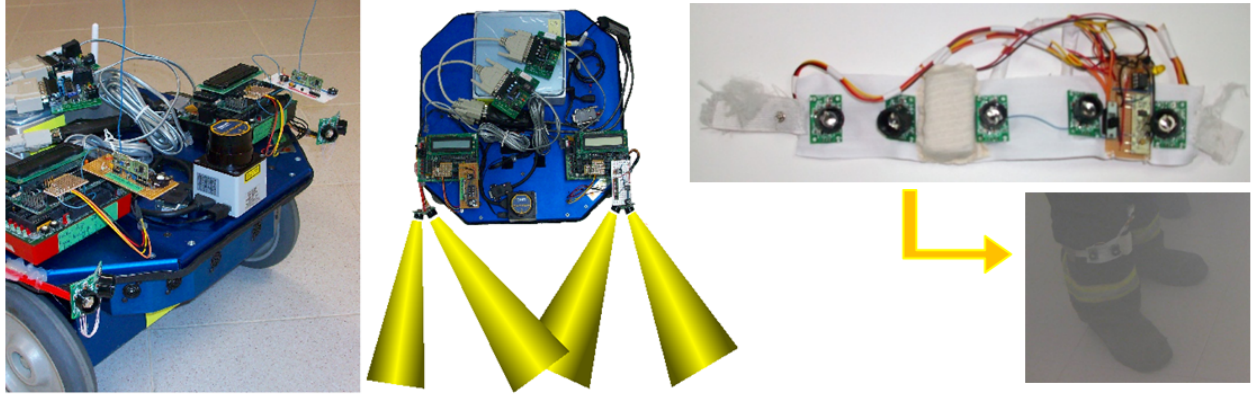
Figure 10. Erratic Videre mobile platform equipped with 2 measurement boards based on TDoA (left). Ultrasonic beam patterns (center). Sonar elastic ring, suitable to be attached to a person leg